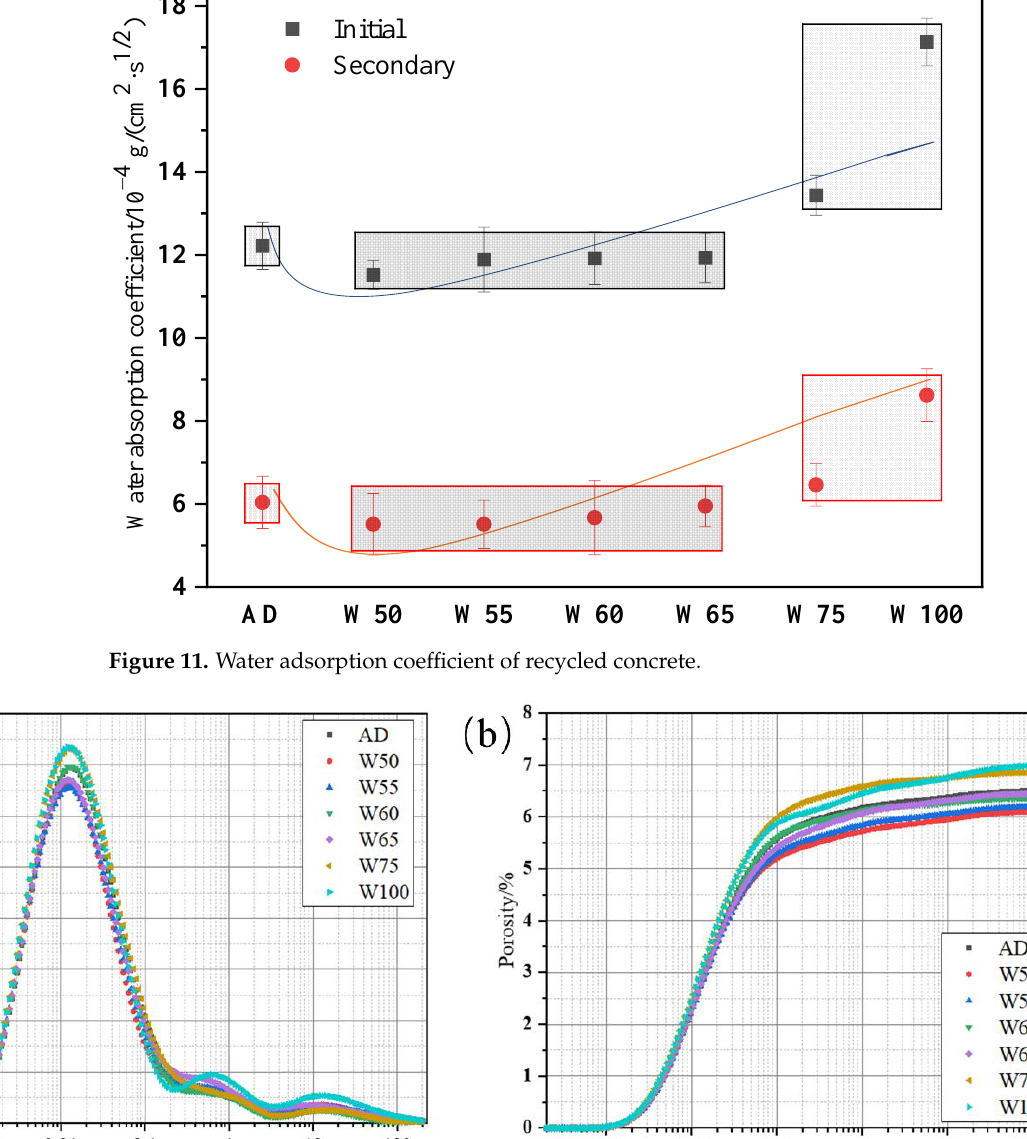
Figure 12. The pore size distribution ( a ) and cumulative porosity ( b ) of recycled concrete.